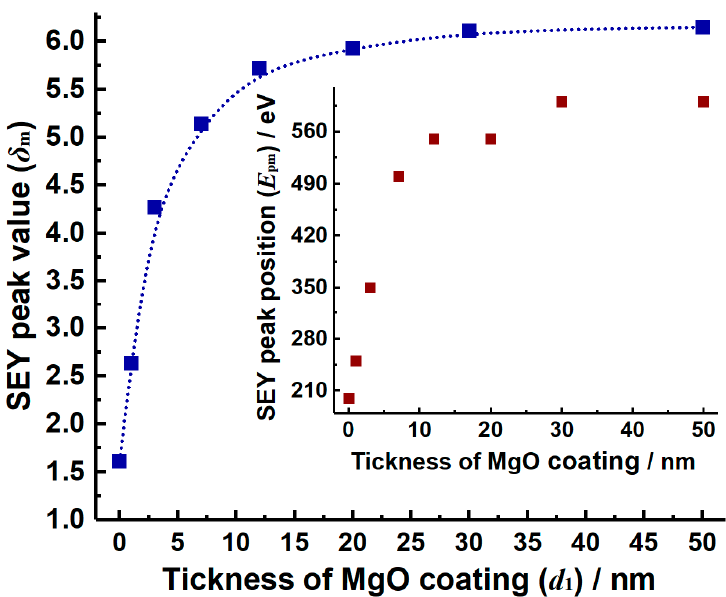
Figure 5. The influence of coating thickness on SEY peak value δ m. Table 1. Typical SEY parameters of MgO/Si double-layer samples.